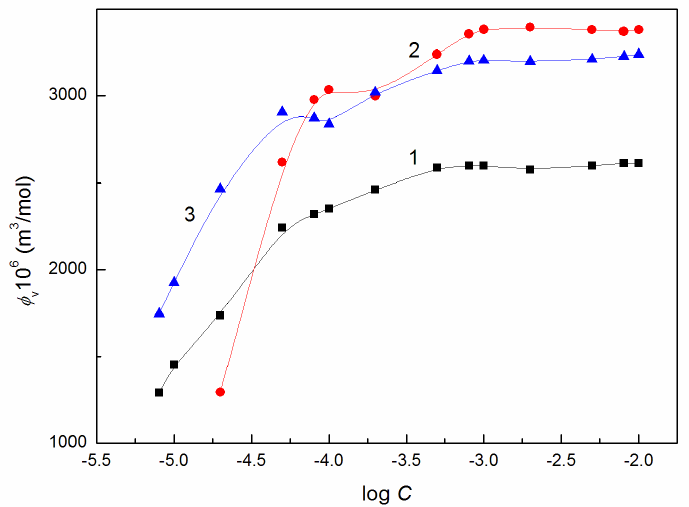
Figure 7. A plot of the apparent molar volume ( φ V ) of the aqueous solutions of AuO + RH40 (curve 1), AuO + ELP (curve 2) and AuO + ELP + RH40 mixtures (curve 3) vs. the logarithm of RH40, ELP or ELP + RH40 concentration (log C ).